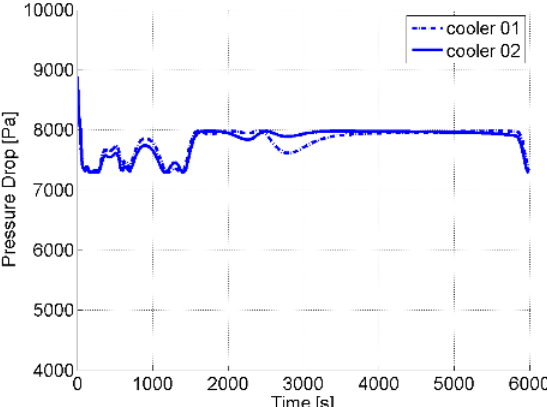
Fig. 8. Pressure drop across the engine in a course of time.